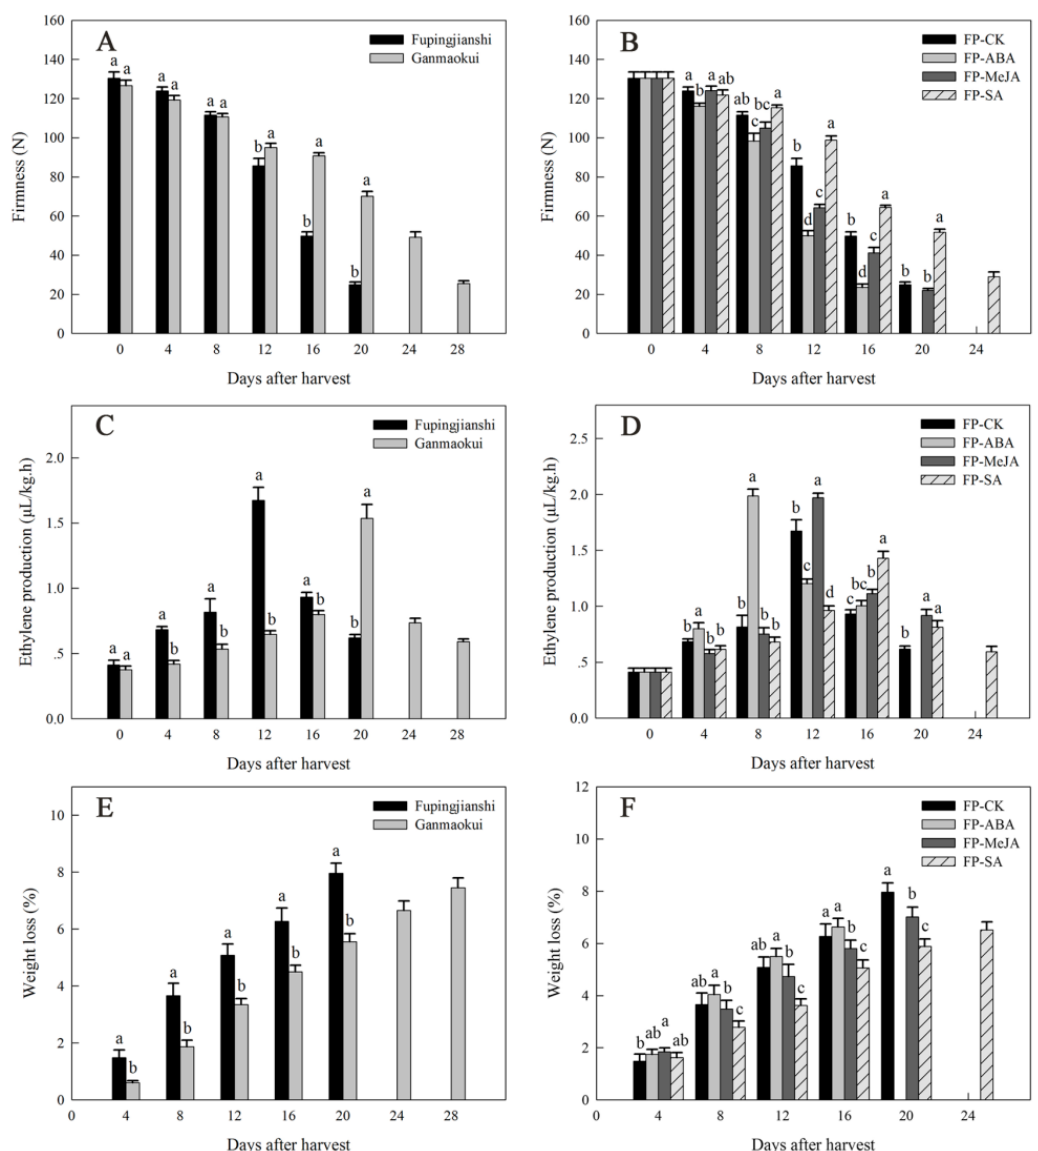
Figure 1. Firmness ( A , B ), ethylene production ( C , D ) and weight loss ( E , F ) in persimmon fruits